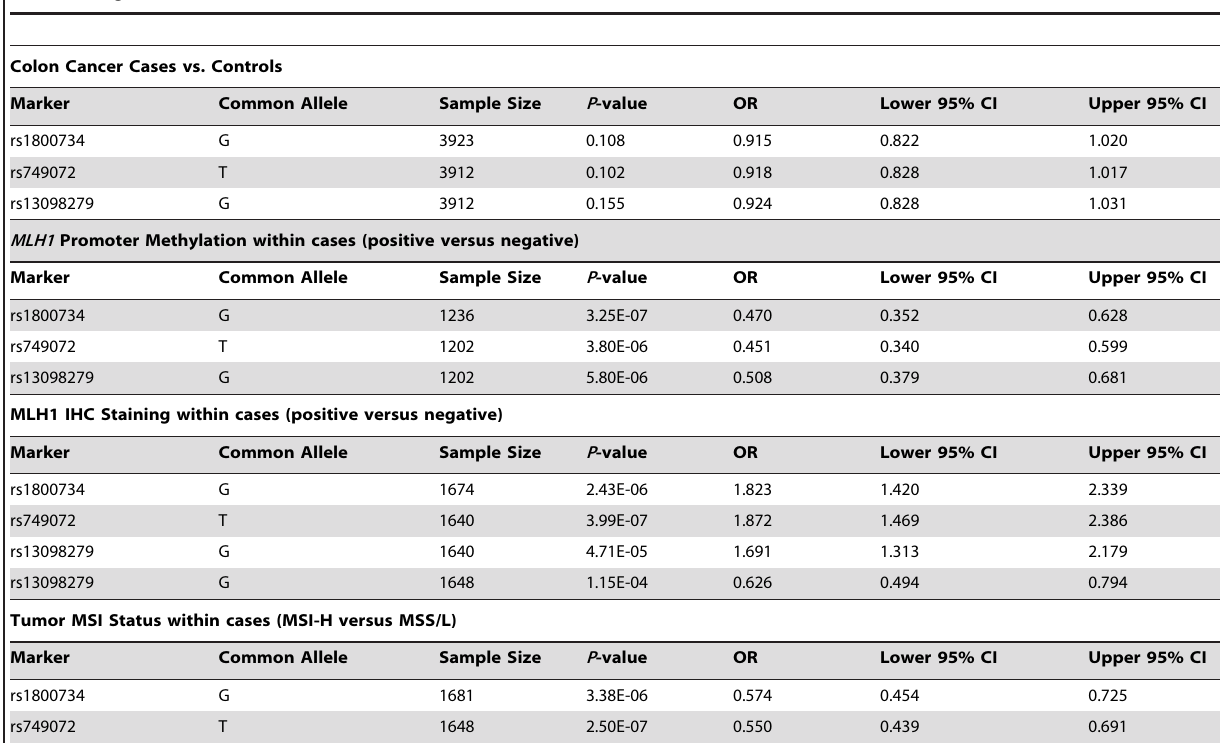
Table 2. Single marker analysis in the combined data for 3 SNPs for CRC cases versus controls, MLH1 promoter methylation, MLH1 IHC staining and MSI tumor status.